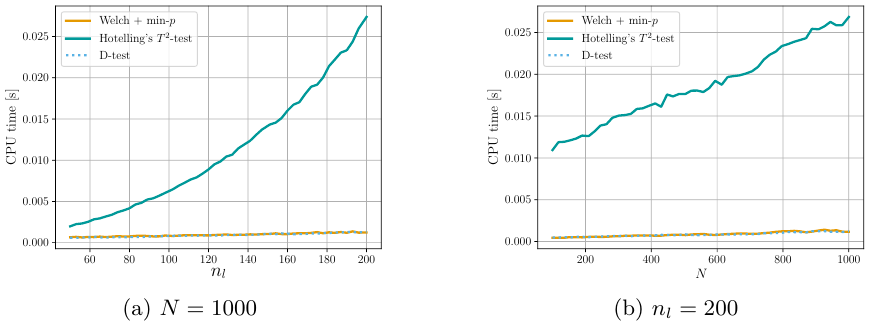
Figure 13: Required CPU time of the leakage detection